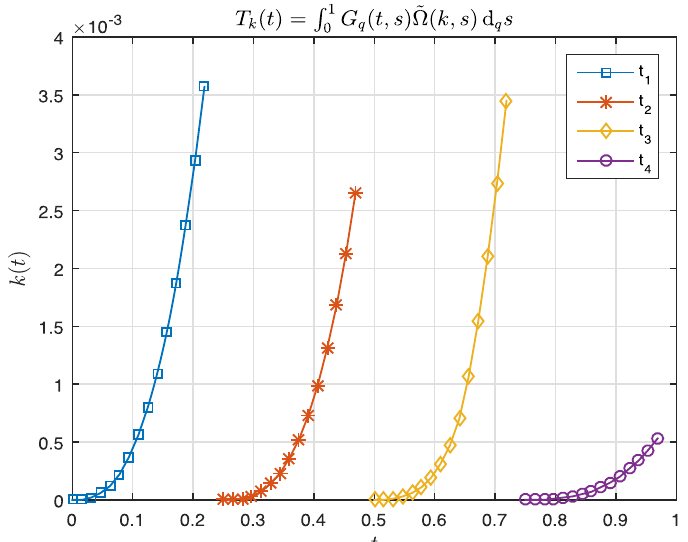
Figure 1: ( ) k t with respect to t for Equations in ( 26 ) in Example 4.1 for